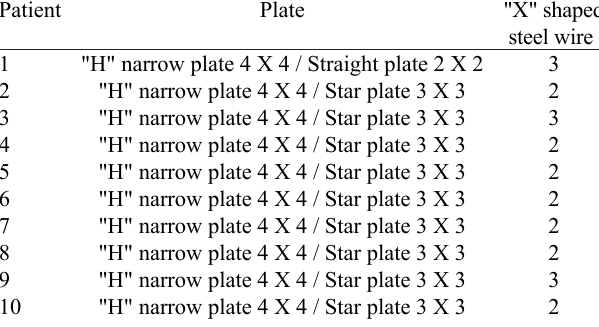
Table 1. How to use the